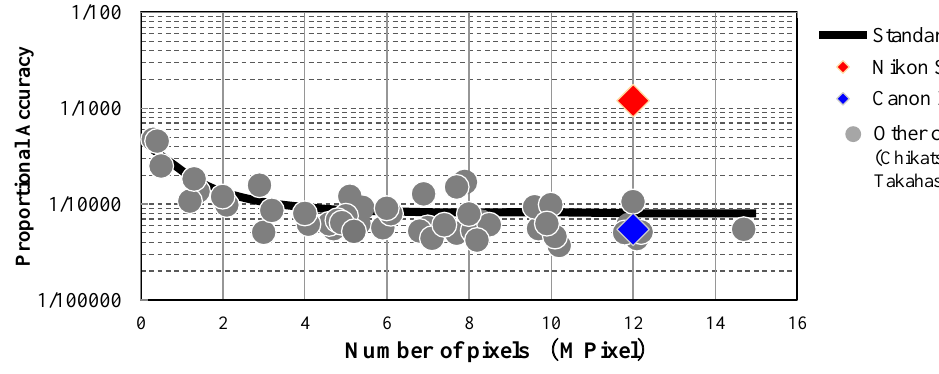
Figure 3. Experimental results